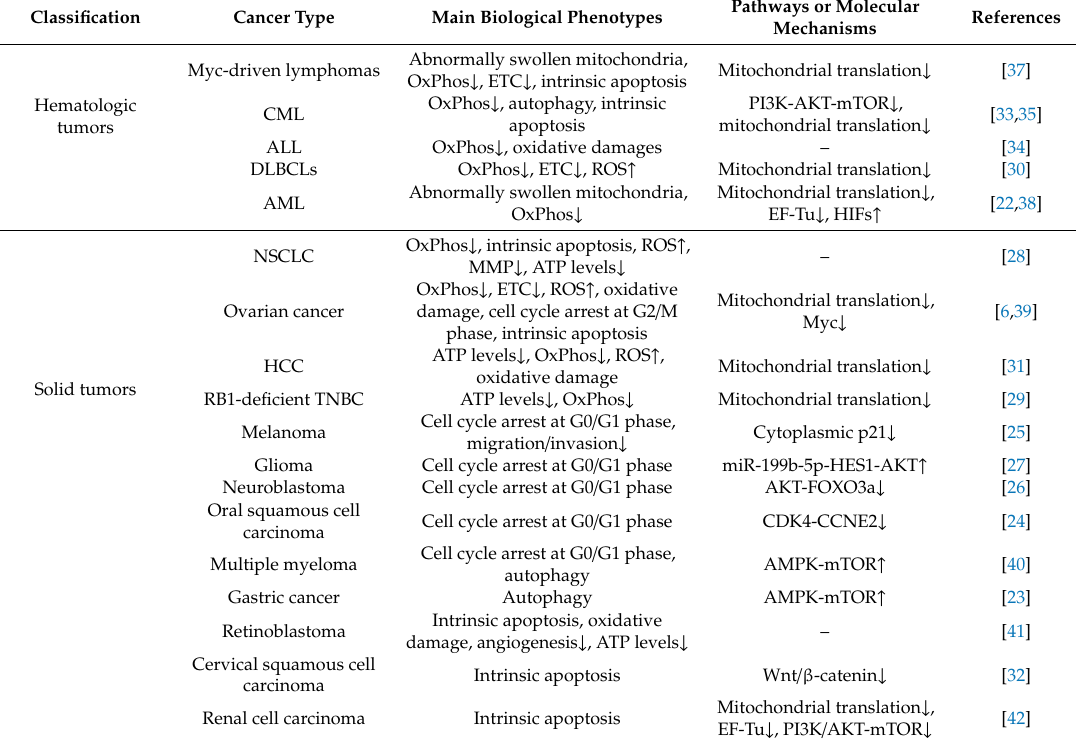
Table 2. Di ff erent biological phenotypes and signaling pathways or molecular mechanisms induced by tigecycline in di ff erent cancer